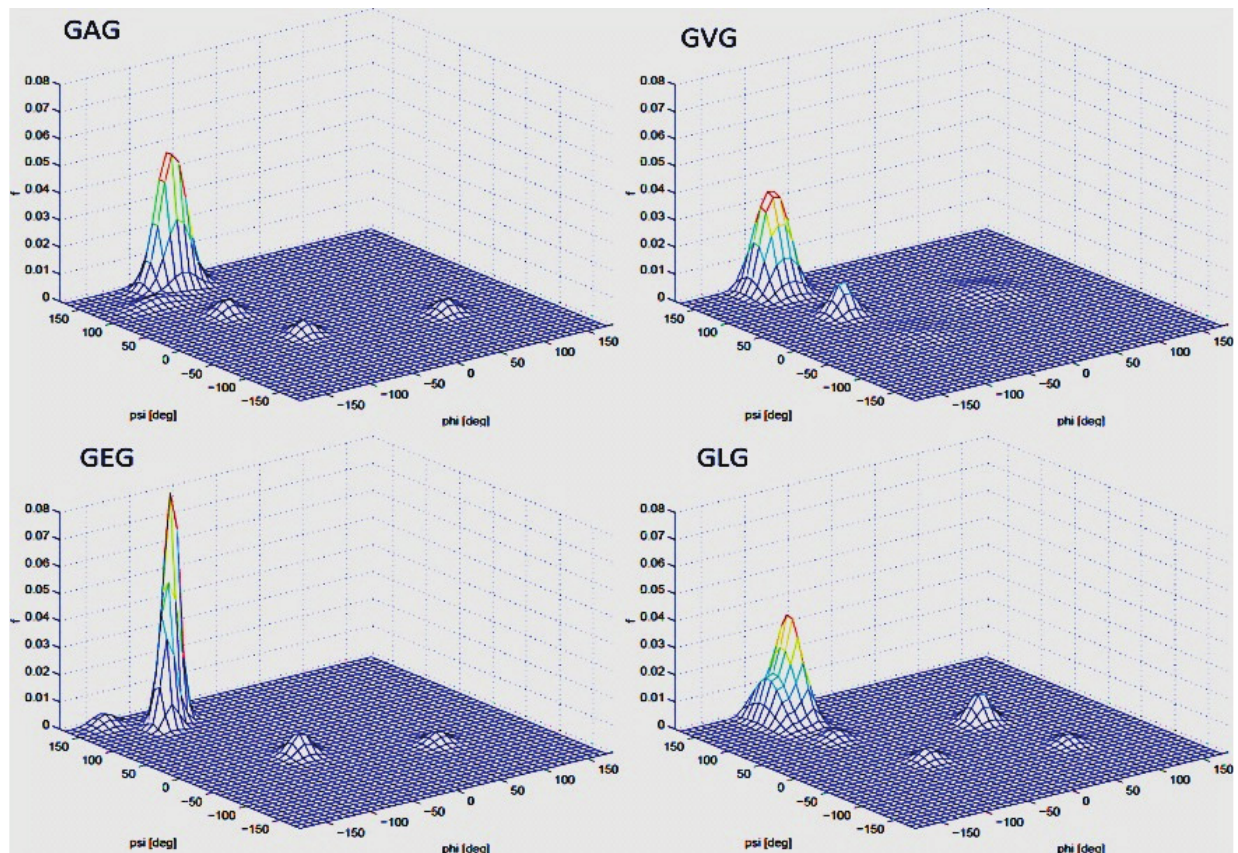
Figure 14. Conformational distributions of the central residue in GAG, GVG, GLG, and GEG obtained from analysis of amide I’ band profiles and J coupling constants, illustrating the 2D distribution approach used by Hagarman et al. (Taken from ref. [52] with